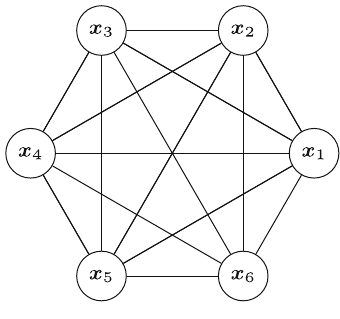
Figure 1: A star topology with six